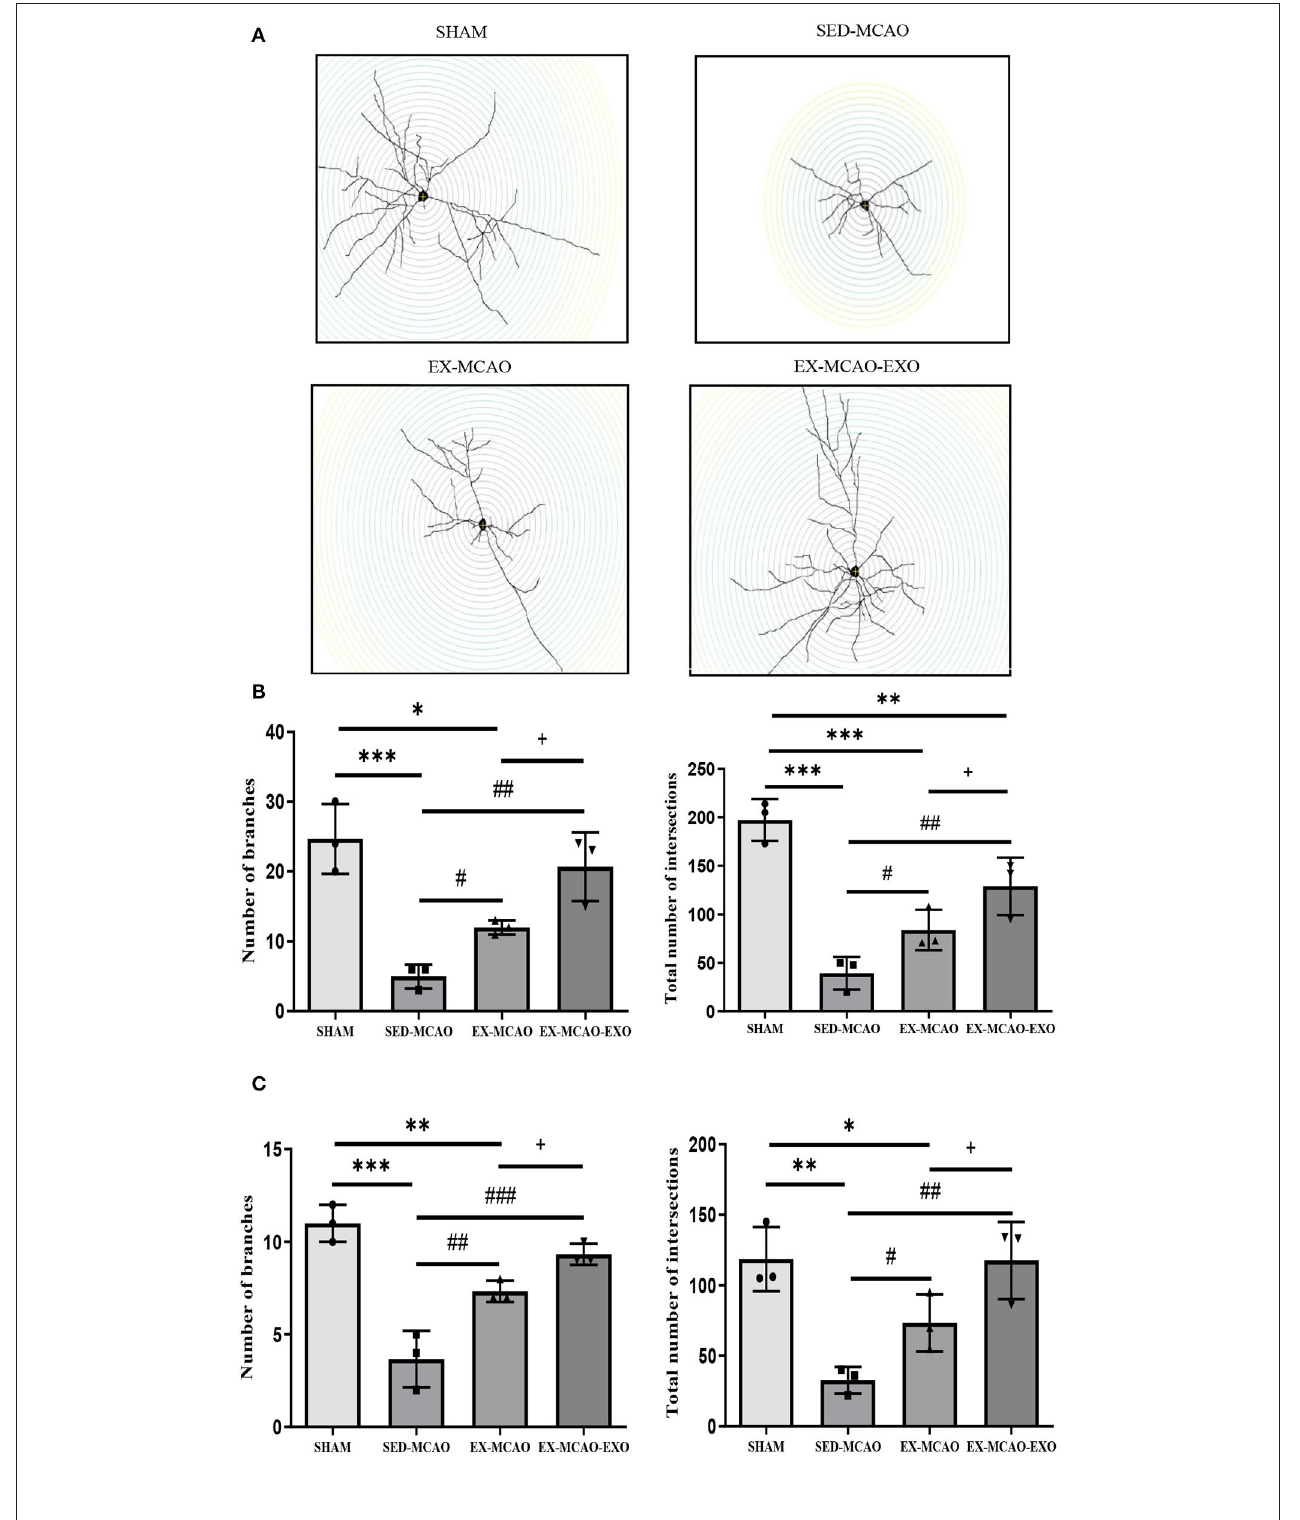
FIGURE 7 | Characteristics of basal and apical dendrites in each group were analyzed by Sholl analysis. (A) Representative images of each group for Sholl analysis, with a step of 10 µ m. (B) Total number of branches and intersections in basal dendrites. (C) Total number of branches and intersections in apical dendrites. * P < 0.05, ** P < 0.01, and *** P < 0.001 compared with the SHAM group; # P < 0.05, ## P < 0.01, and ### P < 0.001 compared with the SED-MCAO group; + P < 0.05 compared with the EX-MCAO group. Mean ± standard deviation. N = 3/group.